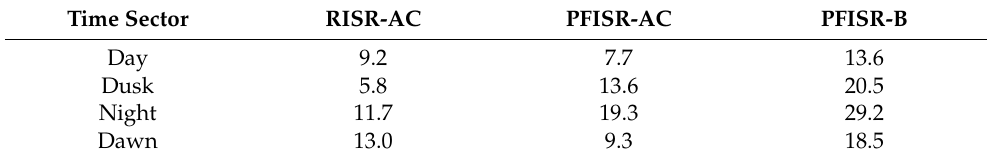
Table 3. Percentages of Cases with Ratio R = N eSwarm /N ePFISR more than 1.3 for Various Time